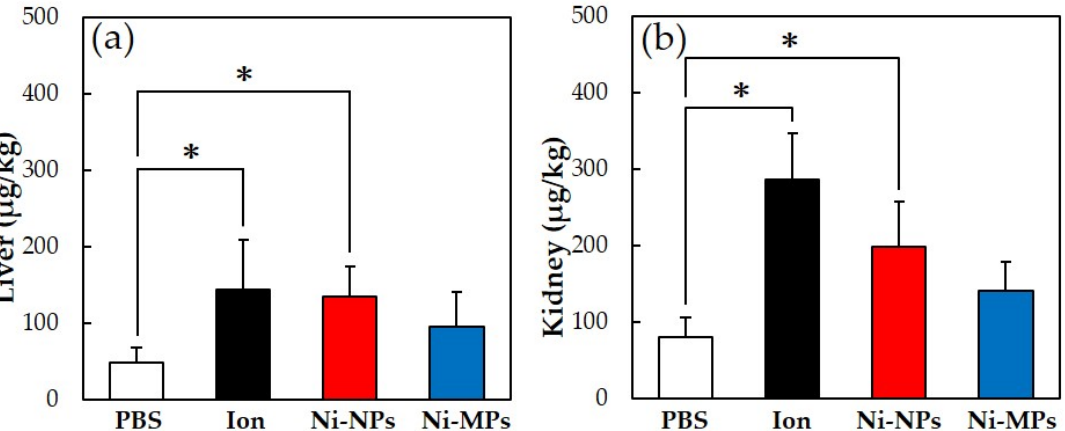
Figure 4. Comparison of nickel accumulation content in each organ after repeated oral administration test. ( a ) Liver, ( b ) kidney. Data are presented as the mean ± S.D., * denotes statistical significance p < 0.05.